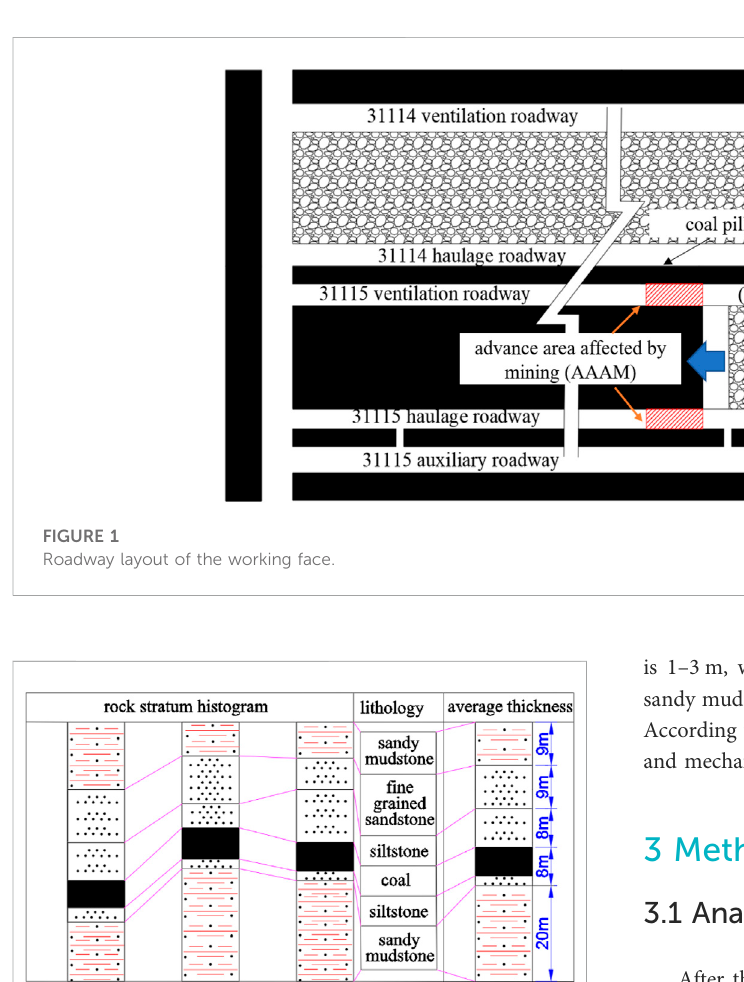
FIGURE 2 Sketch of the rock stratum